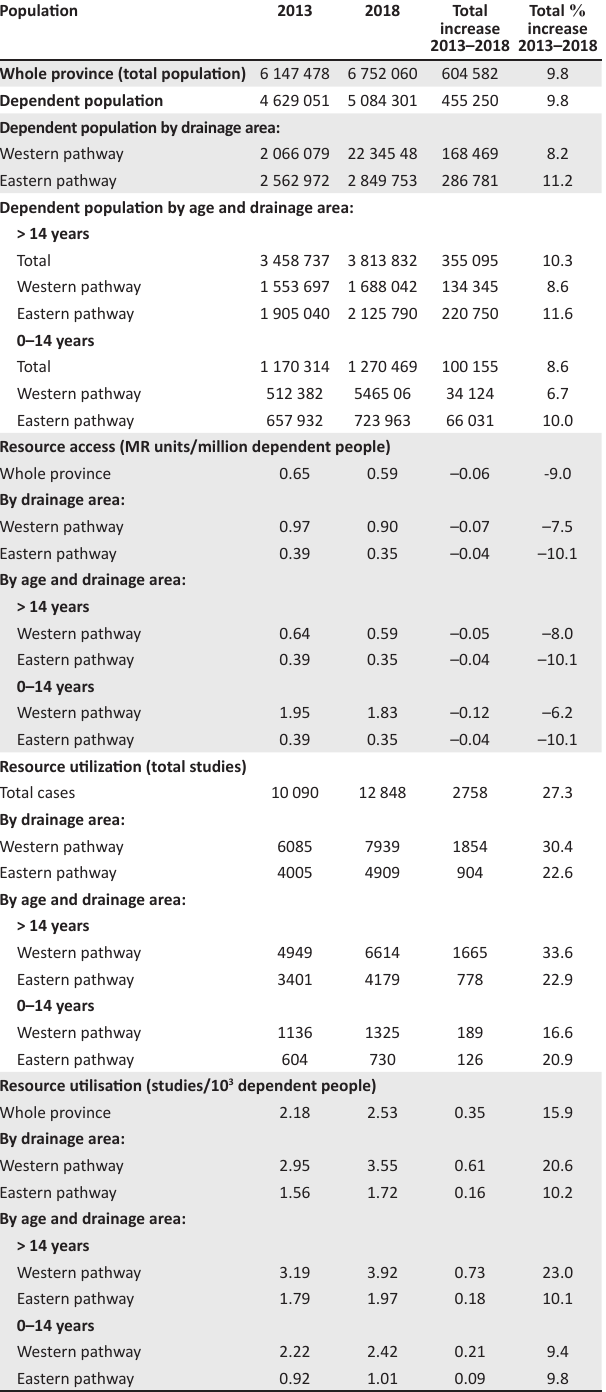
TABLE 3: Drainage populations, resource access and